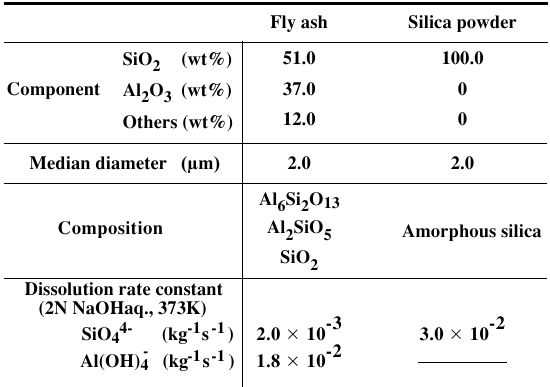
Fig. 1 Schematic diagram of experimental